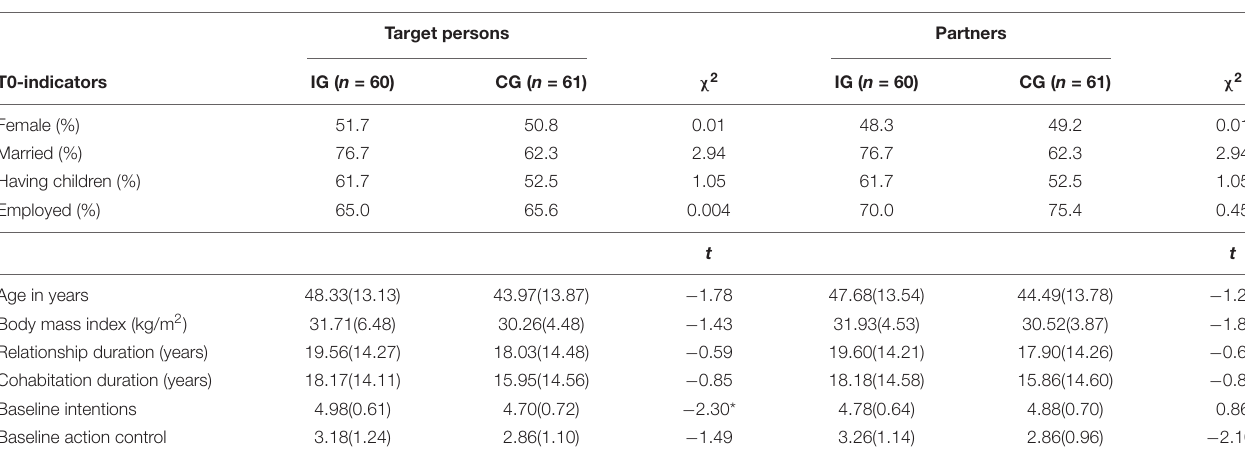
TABLE 1 | Sample characteristics at baseline